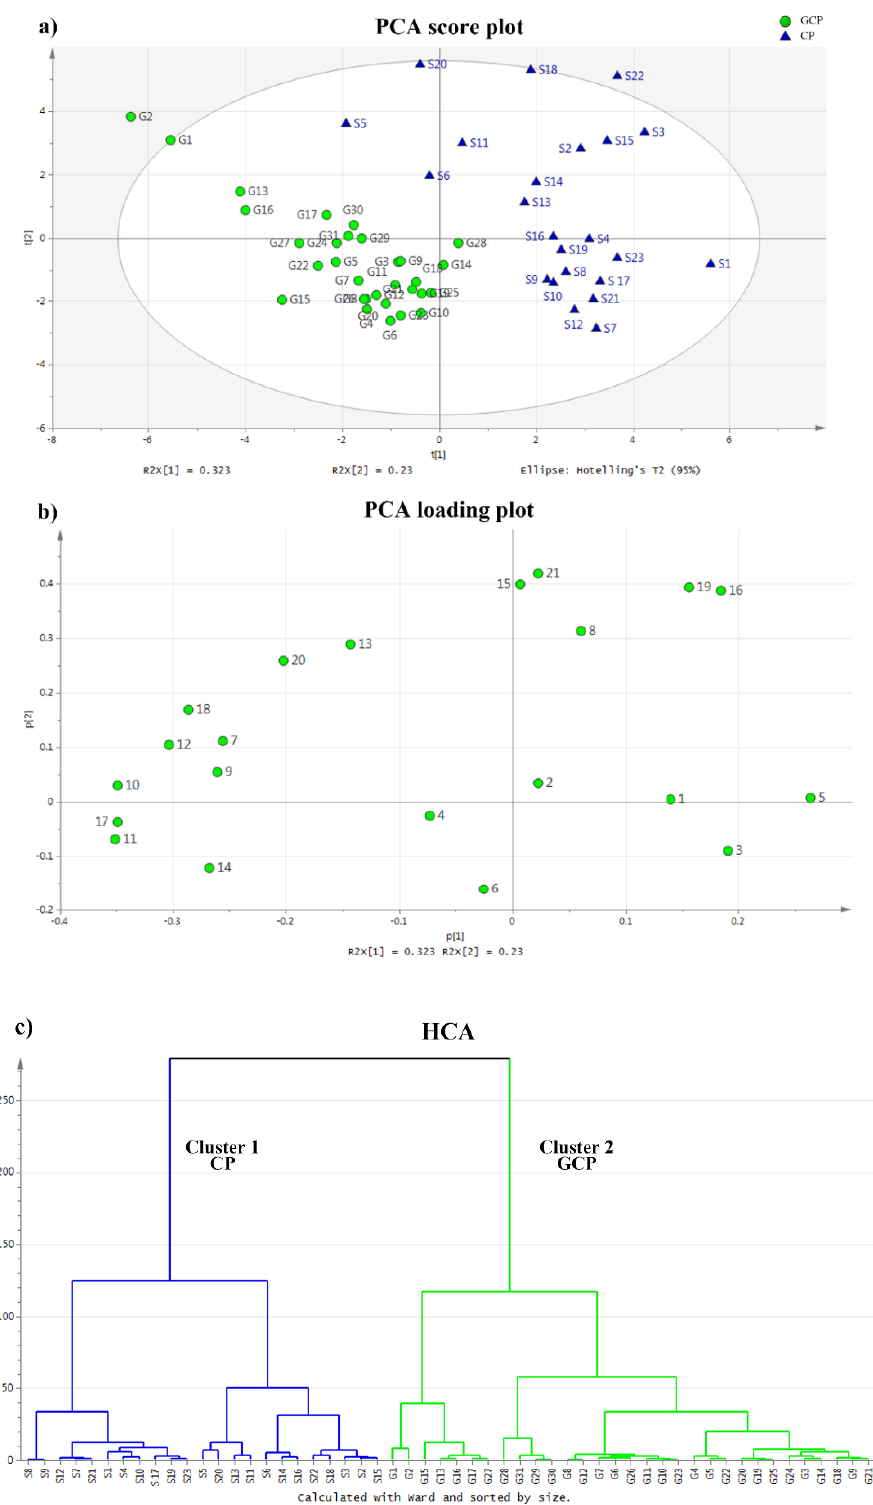
Figure 2. Multivariate data analysis of Citri reticulatae pericarpium (CRP). ( a ) Score plot of the principal-component-analysis (PCA) result. The variances accounted by the first principal component (PC1) and the second principal component (PC2) were 32.3% and 23.0%, respectively. Circles represent “Guangchenpi” (GCP) samples, and triangles represent CP samples. ( b ) Loading plot of the PCA result (PC1 vs. PC2). ( c ) Dendrograms of the hierarchical-cluster-analysis (HCA) result.